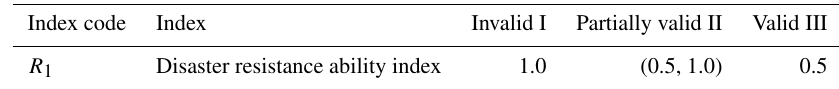
Table 6. Grading and assignment of the disaster resistance ability